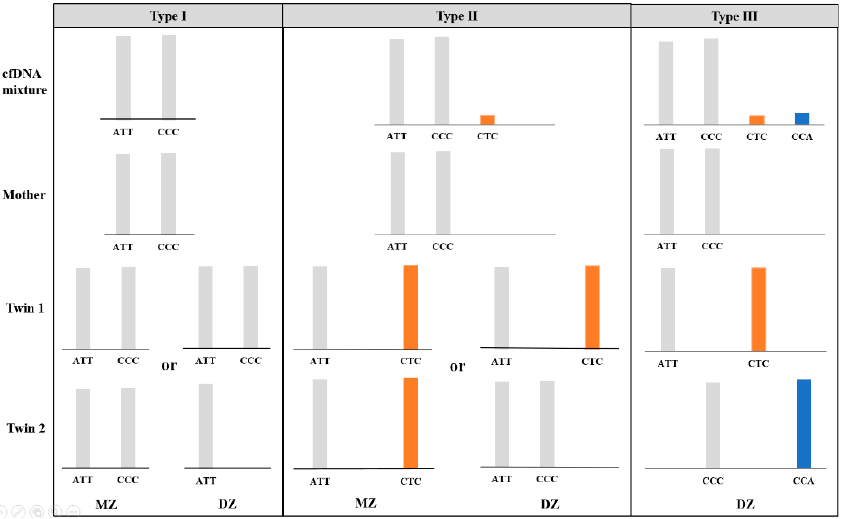
Figure 1. Three possible types of microhaplotype patterns (type I, II and III) in the cfDNA mixture attained from twin pregnancies and examples of genotypic combinations of parents and offspring, without consideration of allele dropout and drop-in. The presence of a “Type III” pattern is considered informative for a dizygotic (DZ) pregnancy.